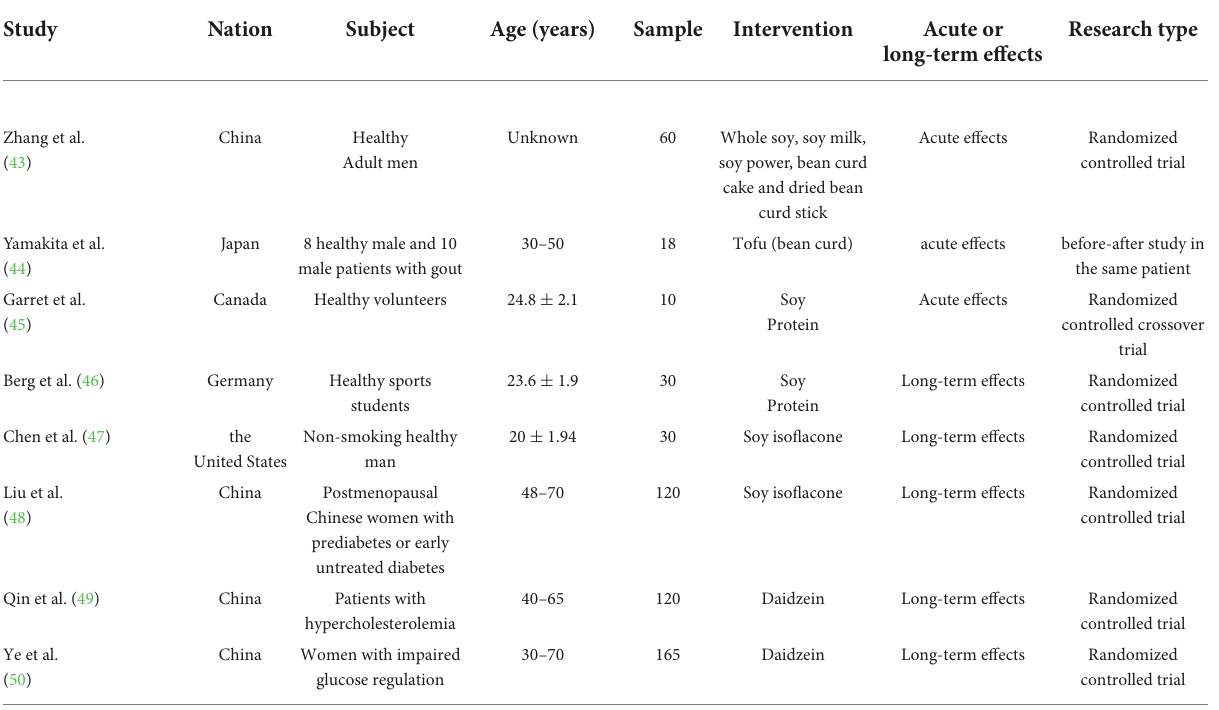
TABLE 1 Characteristics of human clinical